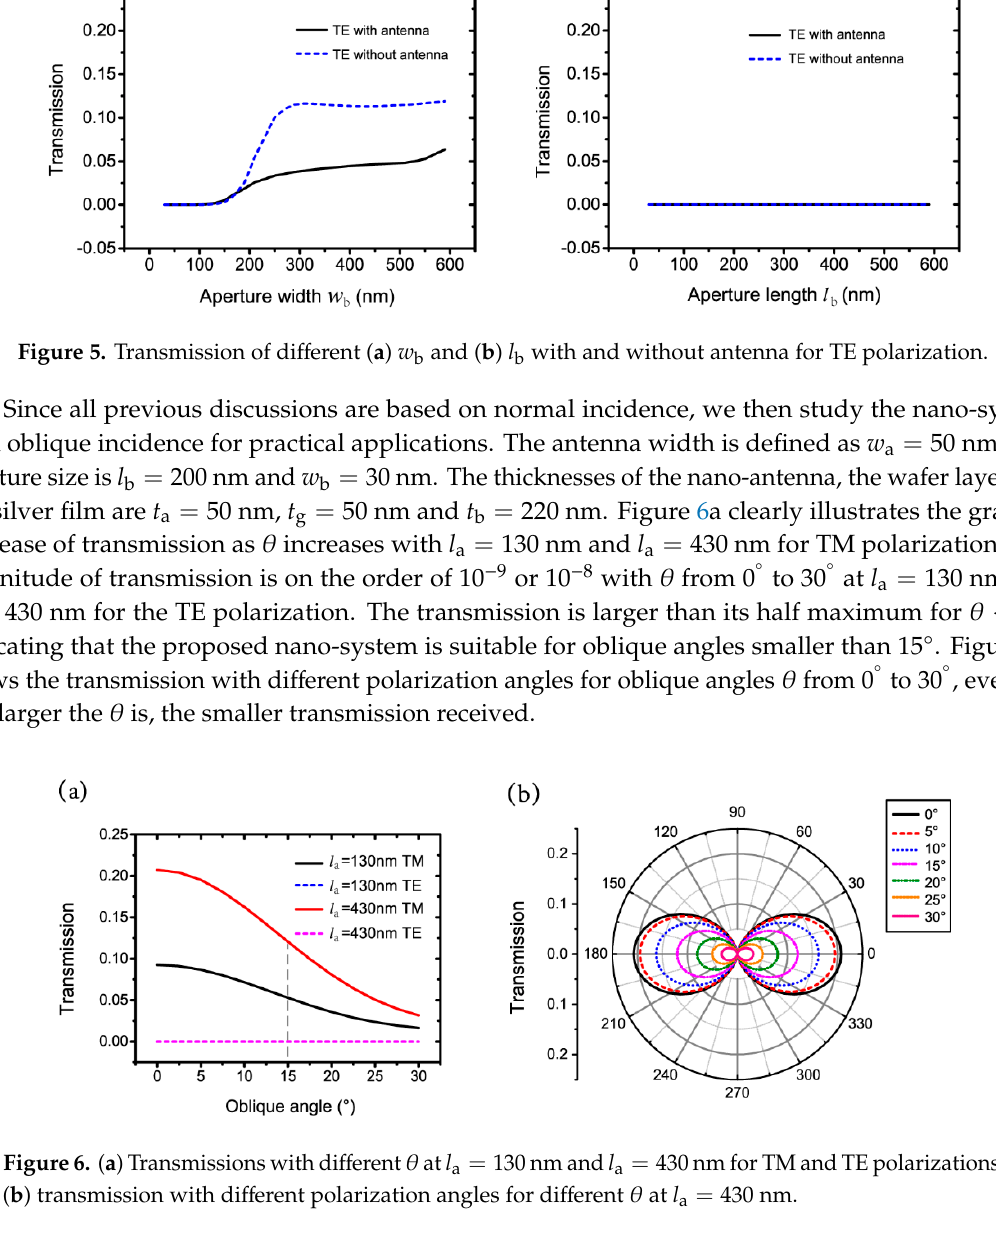
6 of 11 Figure 4. Transmissions with different ( a ) (cid:1875) (cid:2912) and ( b ) (cid:1864) (cid:2912) of the aperture for TM and TE polarizations; extinction ratio with different ( c ) (cid:1875) (cid:2912) and ( d ) (cid:1864) (cid:2912) . To make explicit that the transmission cutoff is not related to the nano-antenna, we also compare